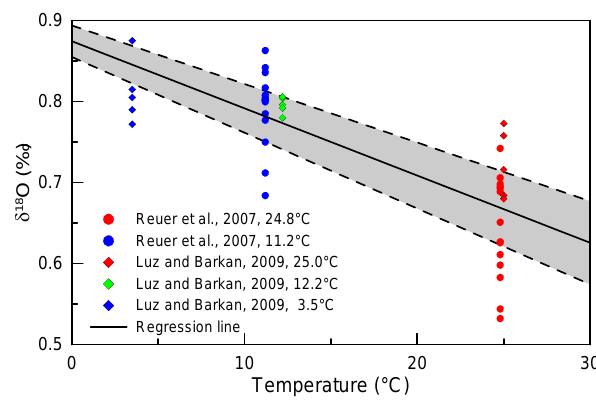
Fig. A2 δ 18 O of dissolved O 2 versus equilibrium temperature (Luz and Barkan, 2009; Reuer et al., 2007). The gray area represents the 1 sigma uncertainty for the regression line.